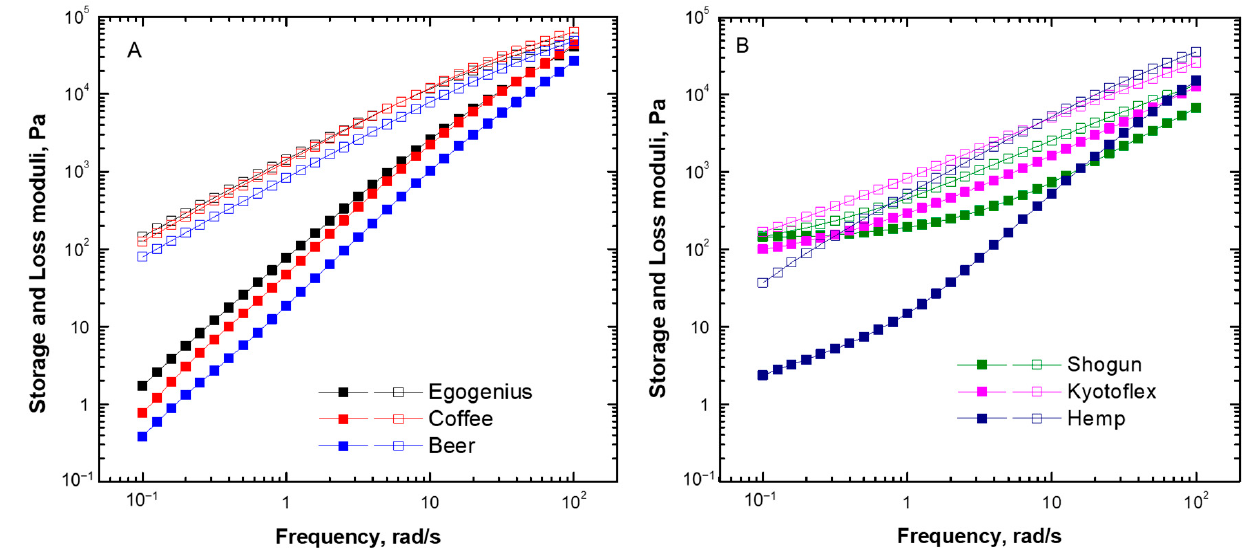
Figure 6. Dynamic moduli as a function of frequency for PLA-based materials showing ( A ) terminal, and ( B ) non-terminal rheological behavior (G ′ full symbols, G ′′ empty symbols).